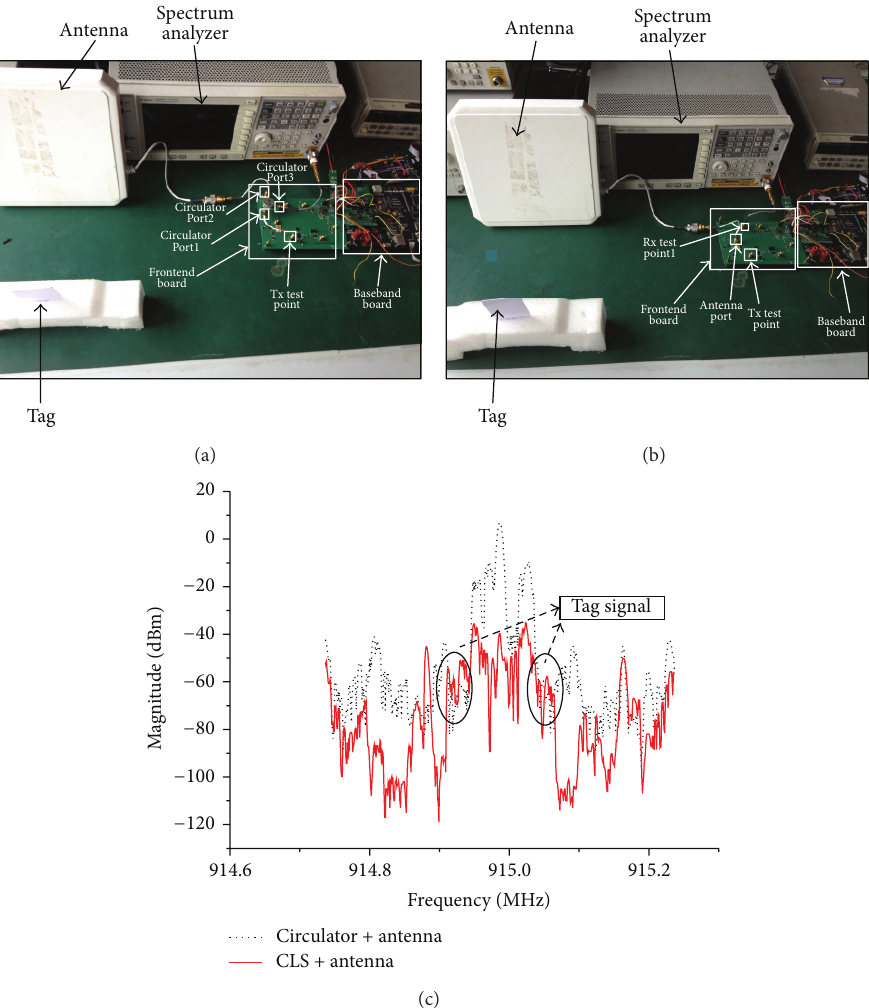
Figure 10: Measurement setup and testing result of the received signal of circulator and CLS circuit, respectively, at a Tx output power of 20 dBm; (a) measurement setup when testing the received signal by using circulator instead of CLS circuit; (b) measurement setup when testing the received signal by using CLS circuit; (c) testing result of (a) and